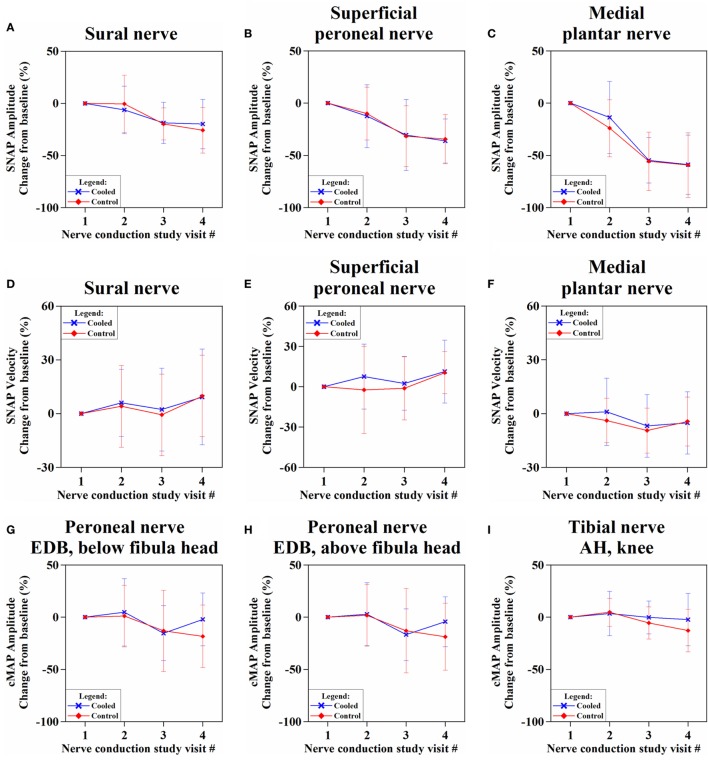
Percentage change of sensory nerve action potential (SNAP) amplitudes (A–C) and velocities (D–F), and compound motor action potential (cMAP) amplitudes (G–I) and velocities (J–L) over four nerve conduction study visits from baseline.